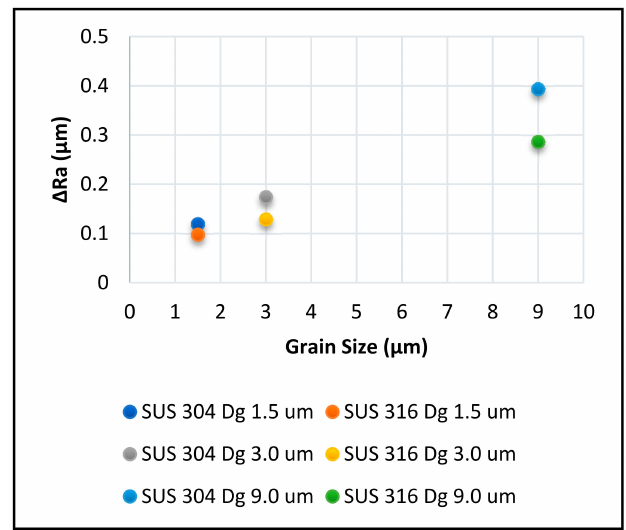
Figure 6. Increasing Ra at high strain